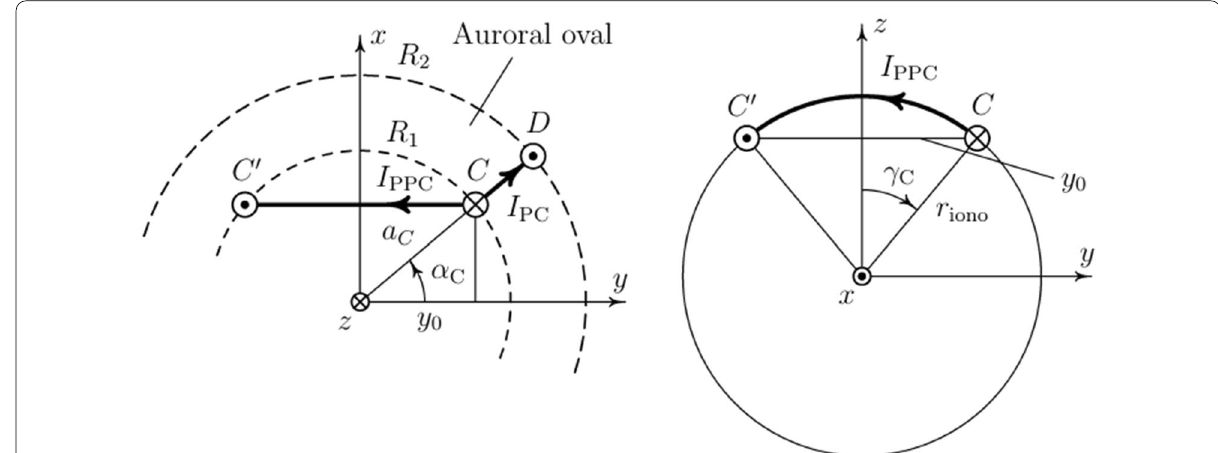
Fig. 20 The geometry considered to derive the magnetic field generated by a wire lying in x = x 0 plane and carrying the polar-cap Pedersen current I PPC along a circular arc between points C and C ′ . The left and right panels show the projections onto the z = z 0 and x = x 0 planes, respectively, where z 0 = r iono cos ϑ R , a C = r iono sin ϑ R (see Fig. 19) and x 0 = a C sin α C . Large crossed and dotted circles represent the flow of FACs 1 1 into and out of the ionosphere,